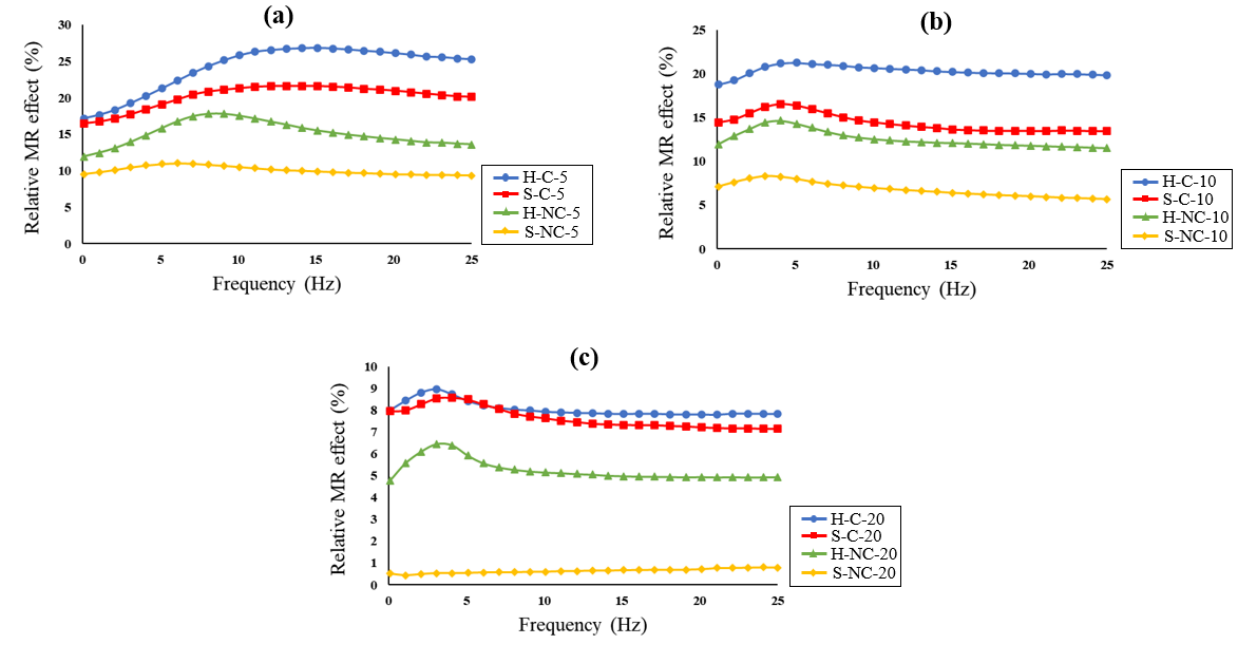
Figure 8. Relative MR effect of the MRE samples: ( a ) at 5%; ( b ) at 10%; ( c ) at 20% volume fractions.